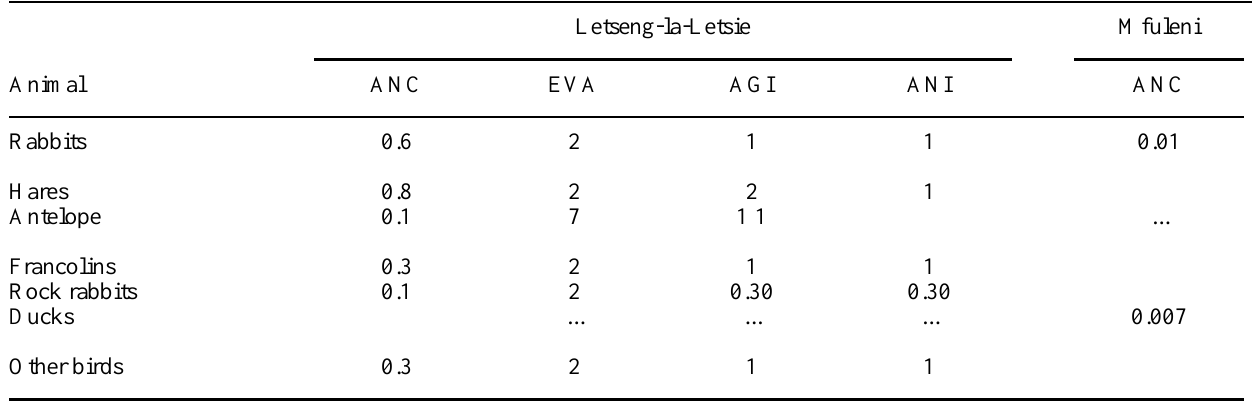
Table 4 . Animals caught around the Letseng-la-Letsie and Mfuleni wetlands. ANC = average number caught by hunting households, EVA = estimated value per animal in U.S. dollars, AGI = average gross income in U.S. dollars, and ANI = average net income in U.S.